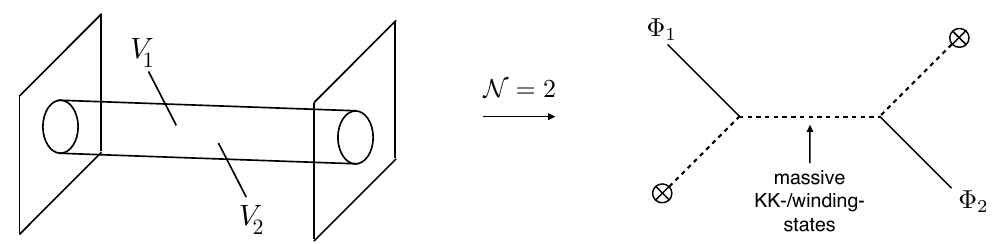
Figure 1 . Only BPS states contribute in = 2 sectors. In the string theory picture on the left, N V 1 and V 2 are the vertex operators of any of the moduli and (cid:8) 1 and (cid:8) 2 are the corresponding (cid:12)elds in the (cid:12)eld theory picture on the right. Moreover, the crosses on the right hand side stand for the D-brane or O-plane